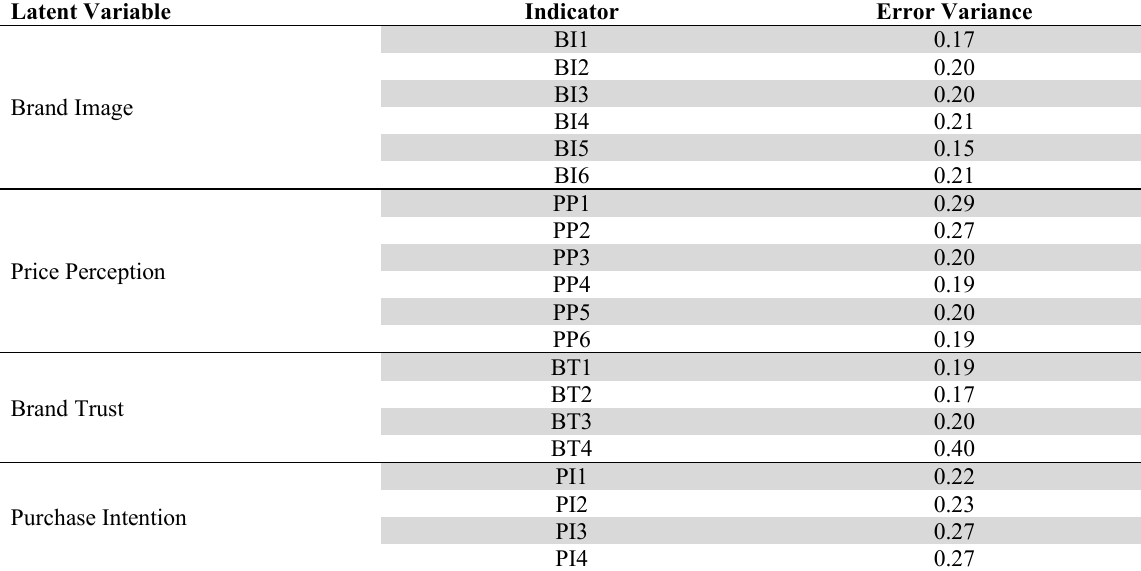
Error Variance Values